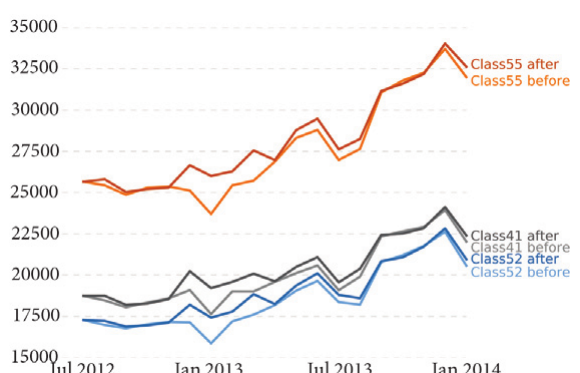
Fig. 3. Mean GVW in kg of Class 55, 52 and 41 vehicles before and after adjusting for temperatures influence – A1